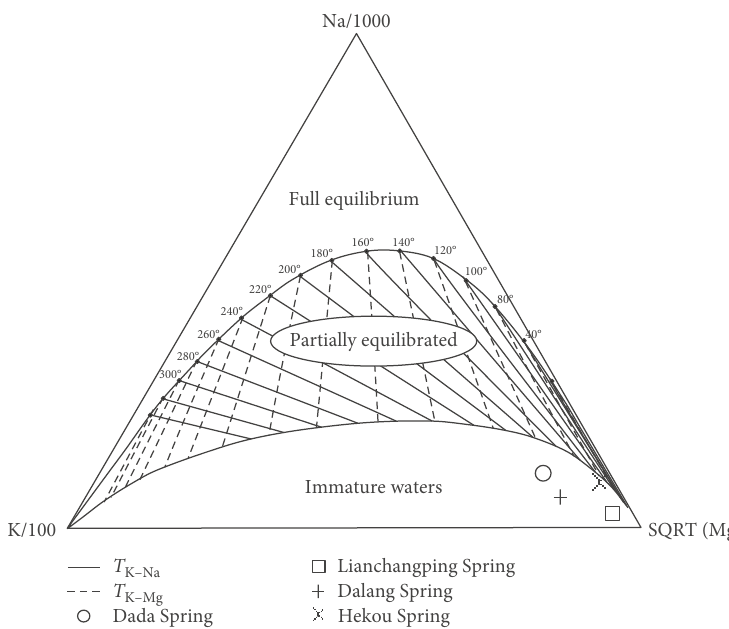
Figure 4: Na-K-Mg Giggenbach